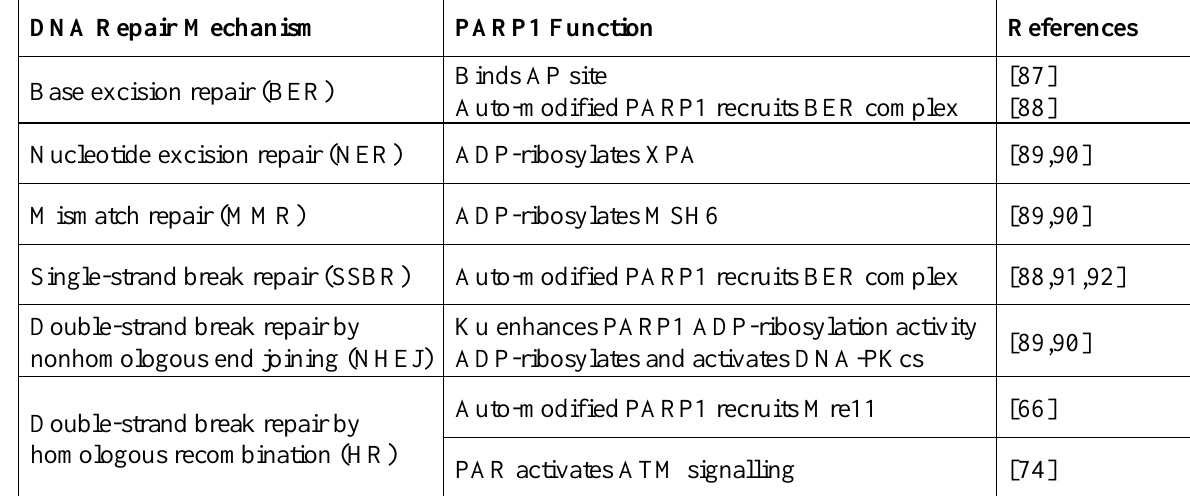
Table 1. Involvement of PARP1 and PAR in DNA repair